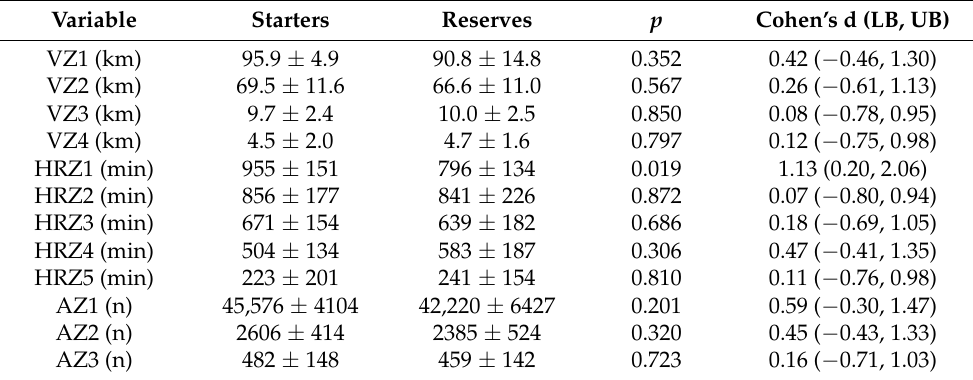
Table 3. Total accumulated practice session workloads in NCAA Division III women’s soccer by starting status (mean ± SD). Variable Starters